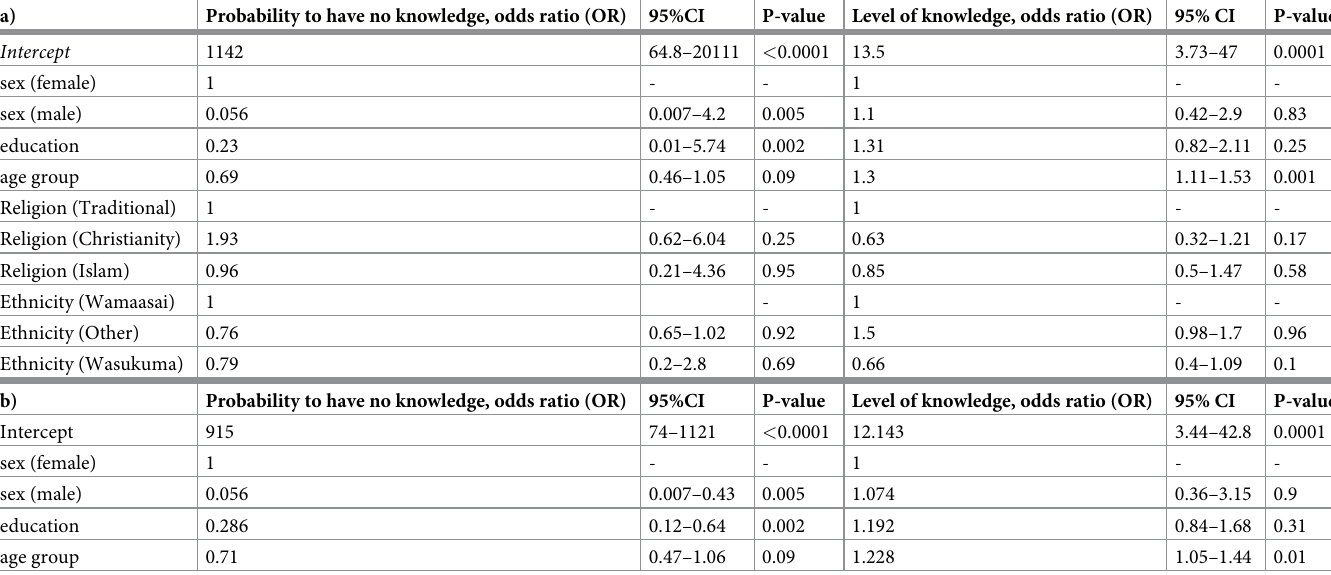
Table 5. Predictors for knowledge and knowledge level of brucellosis by agro- pastoralists in Tanzania in a) the null model and b) the final